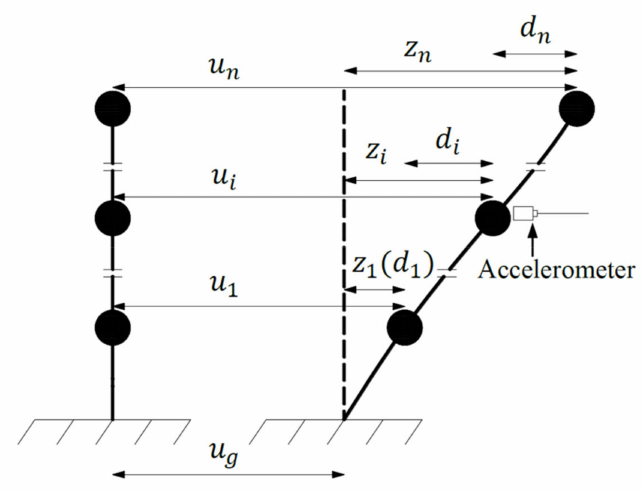
Figure 1. MDOF structure subjected to seismic